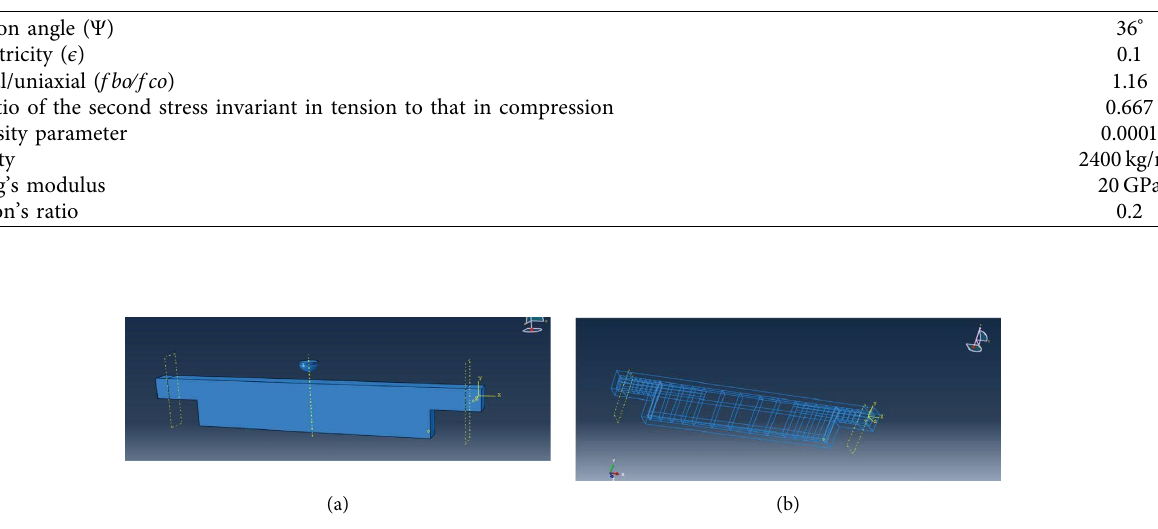
Table 3: Input material data for concrete.